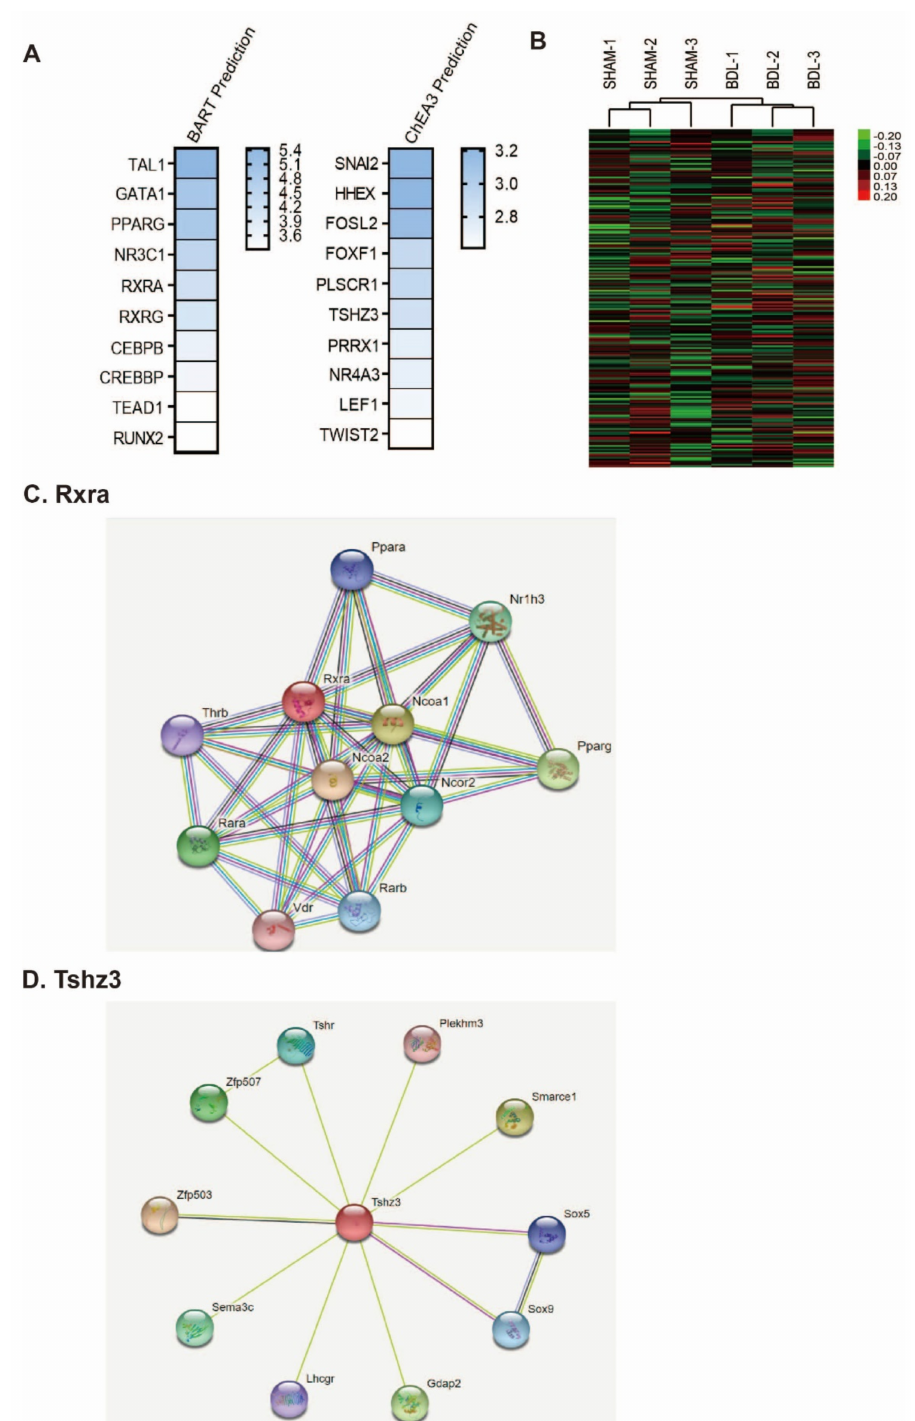
Figure 4. Transcriptional analysis of the common genes in the BDL mouse group. ( A ) BART prediction and ChAE3 prediction transcription factor analysis. ( B ) Heatmap of well grouping between the groups. ( C , D ) Signal networking